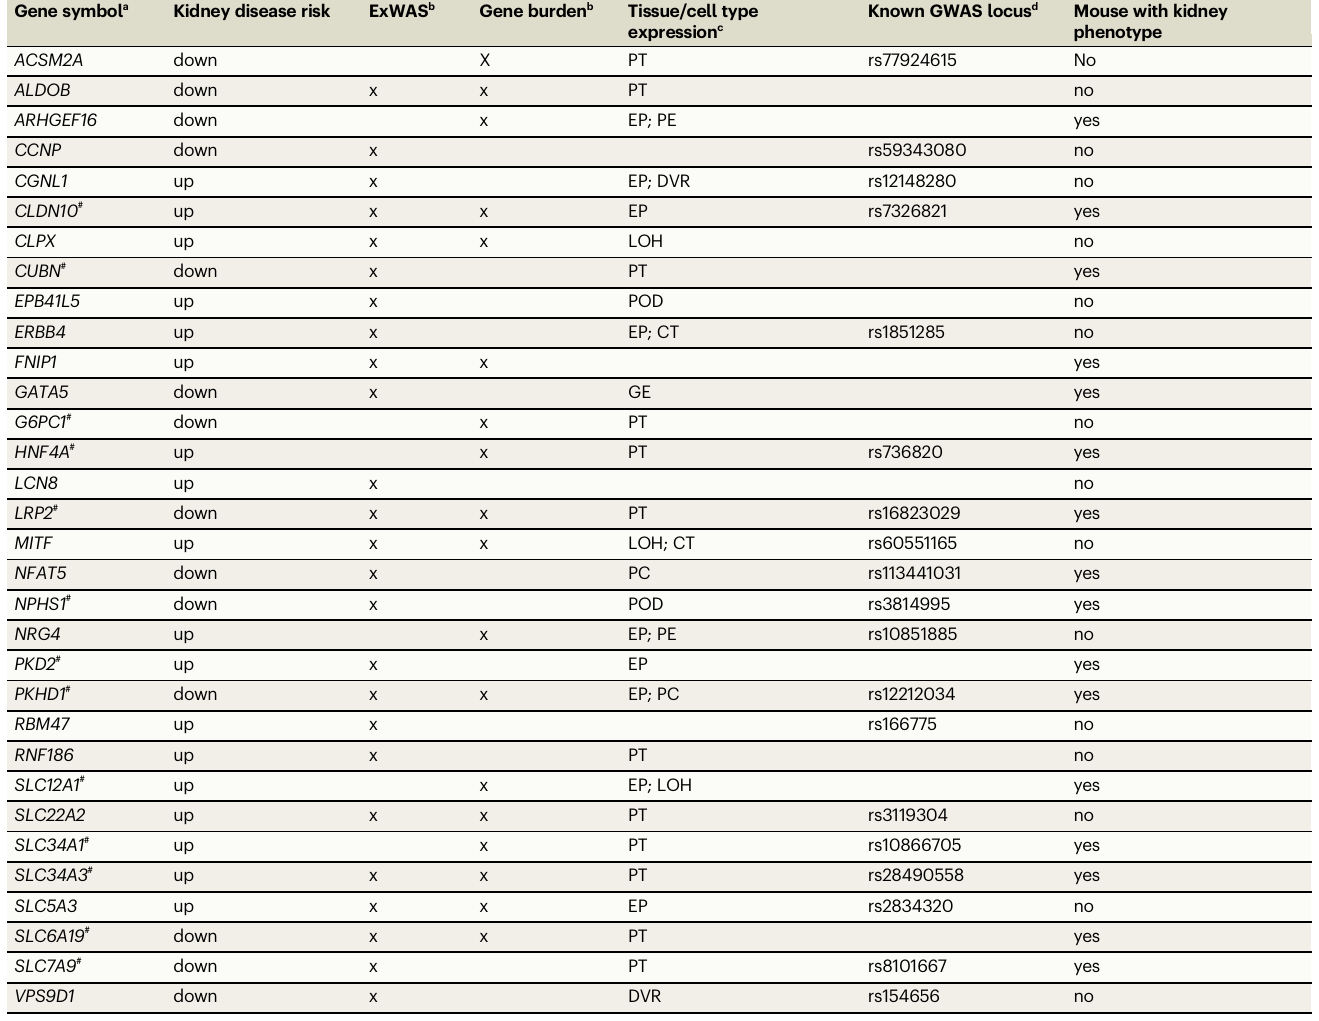
Table 1 | Summary of evidence for a gene associated with kidney function Gene symbol a Kidney disease risk